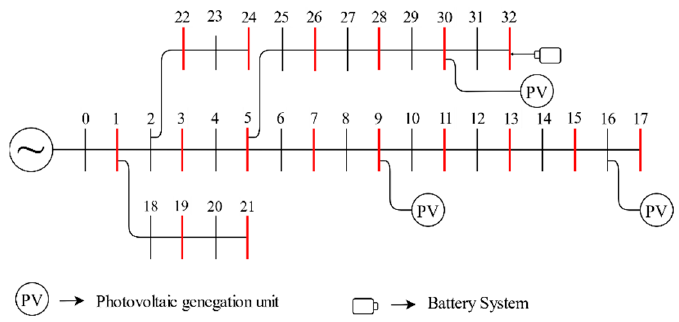
Figure 6. Battery allocation obtained by solving the optimization problem using the IRR.